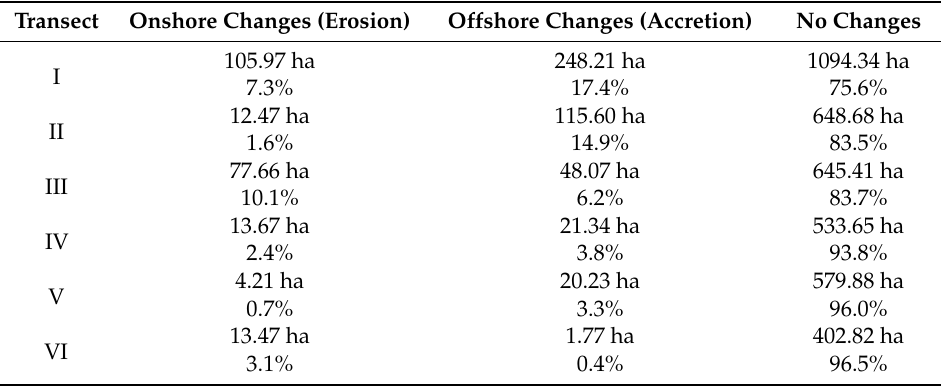
Table 7. Quantitative assessment of morphology of the shoreline